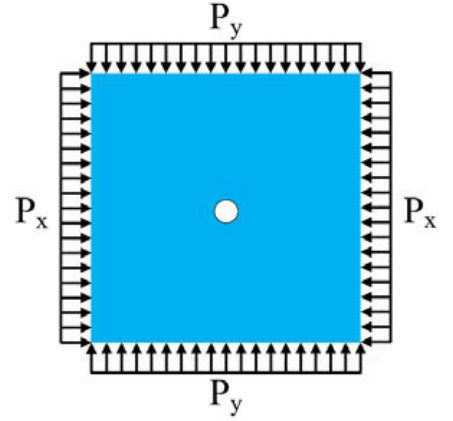
Figure 9. Analysis model for in ‐ situ stresses. Table 3. Six analysis cases under different in ‐ situ stresses.